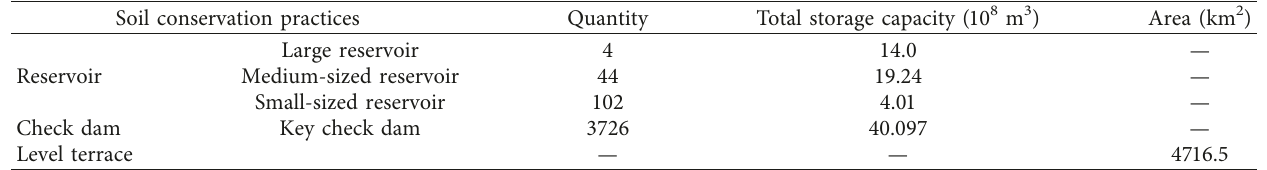
∗ S represents the sediment yield of the HLR. Table 8: Quantity of soil conservation practices by 2011 in the HLR. Soil conservation practices